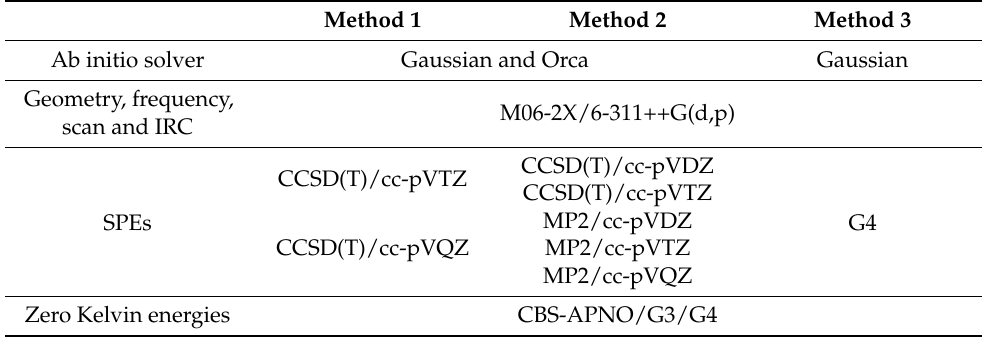
Table 1. Quantum chemical methods and ab initio solvers used in this study.